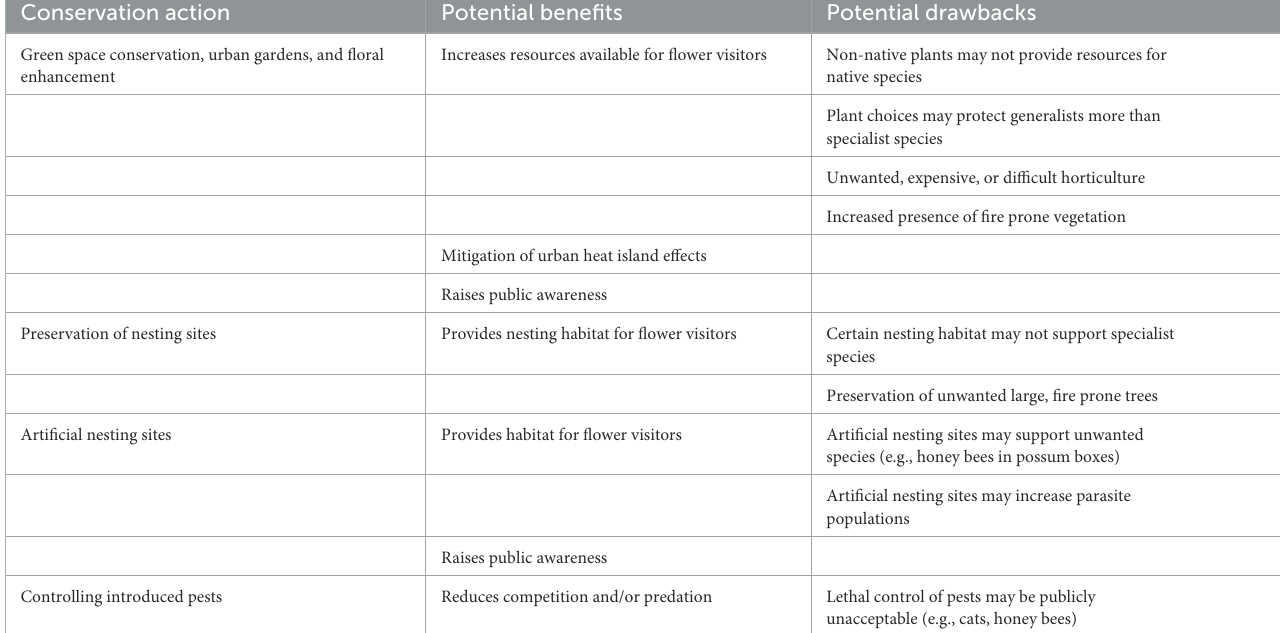
TABLE 1 List of key conservation actions for flower visitors in urban environments Down Under, including benefits and potential drawbacks. Conservation